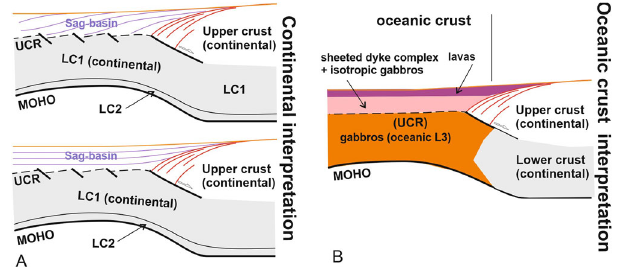
Fig. 5 Distinct interpretations for the FLF crust. A Continental interpretation. The top and left diagrams refer to distinct seismic facies observed in the basin. B Alternative oceanic-crust interpretation from seismic data from the same margins 22